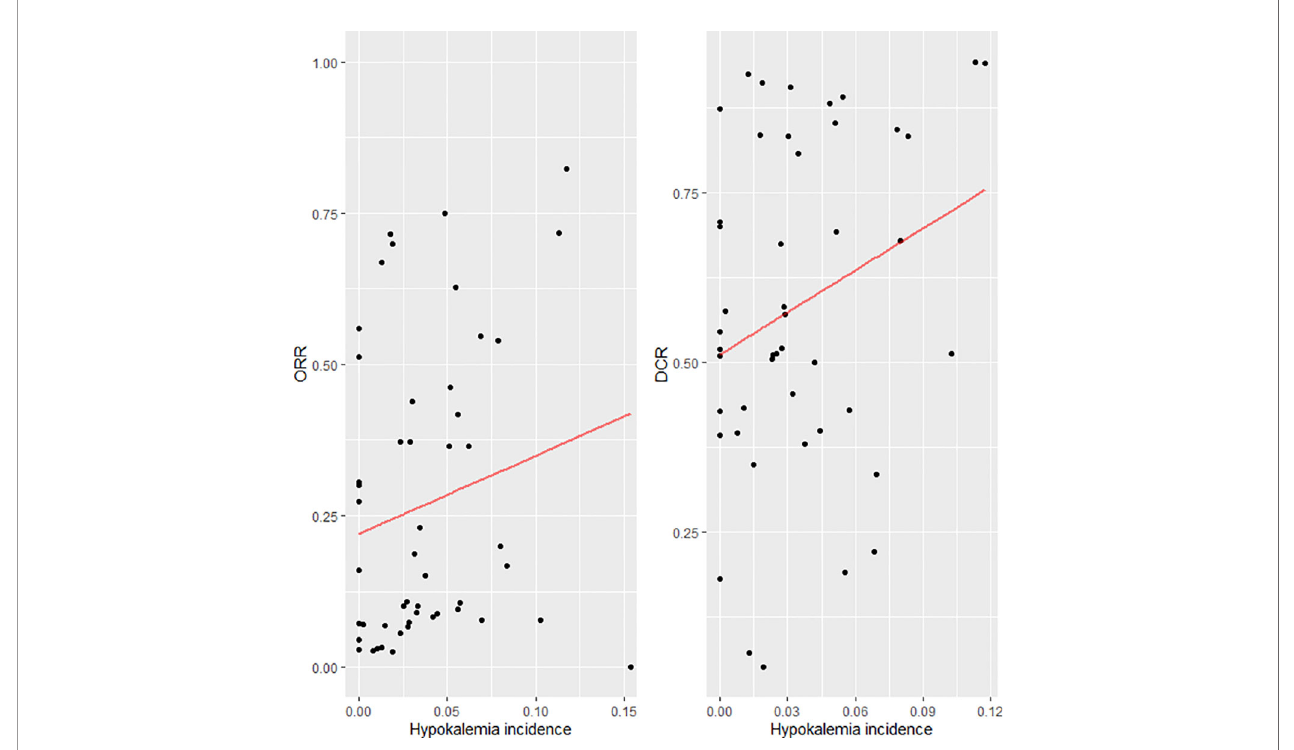
FIGURE 2 | Scatter plot and fi tted line for the incidence of hypokalemia and objective response rate (ORR)/disease control rate